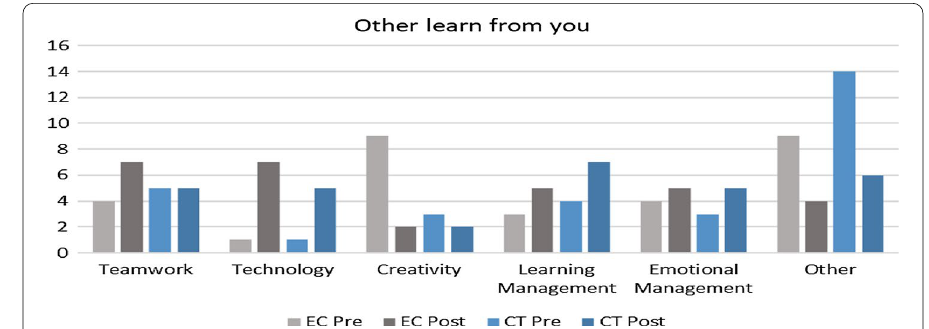
Fig. 8 Change in perception pre and post-intervention based on aspects teammates learned from